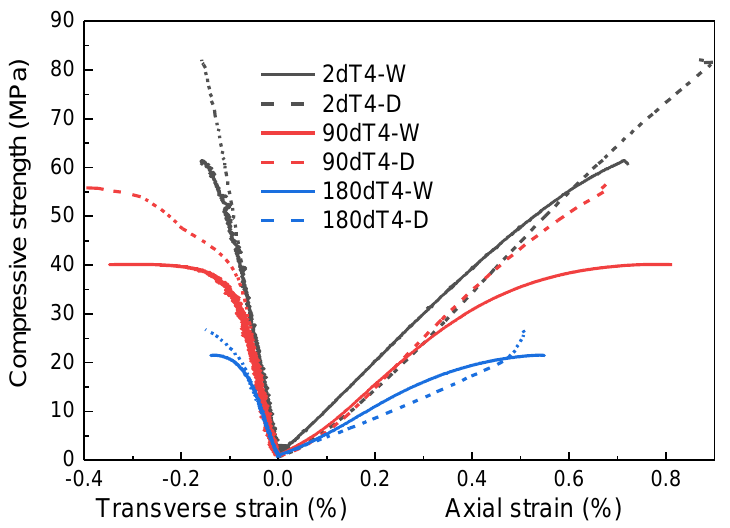
Figure 6. Influences of ( a ) specimen sizes; ( b ) and ( c ) sample quantity on the MIP test results. The compressive strength of set cement is known to increase with the degree of drying due to the reduced effect of pore water pressure and changes in C-S-H structure. Conversely, drying may also lead to shrinkage and cracks in cement-based materials, thereby damaging their mechanical integrity. The stress–strain curves of saturated samples were compared with those of vacuum-dried samples in Figure 7. Clearly, the measured compressive strength increased significantly after sample drying, while the changes in Young’s modulus (slope of stress vs. axial strain curves) were relatively small. The amount of increase in compressive strength due to drying ranged from 29.3% to 37.5% at different curing times. The test results shown here suggest that no significant damage was induced in the test samples during the drying process.